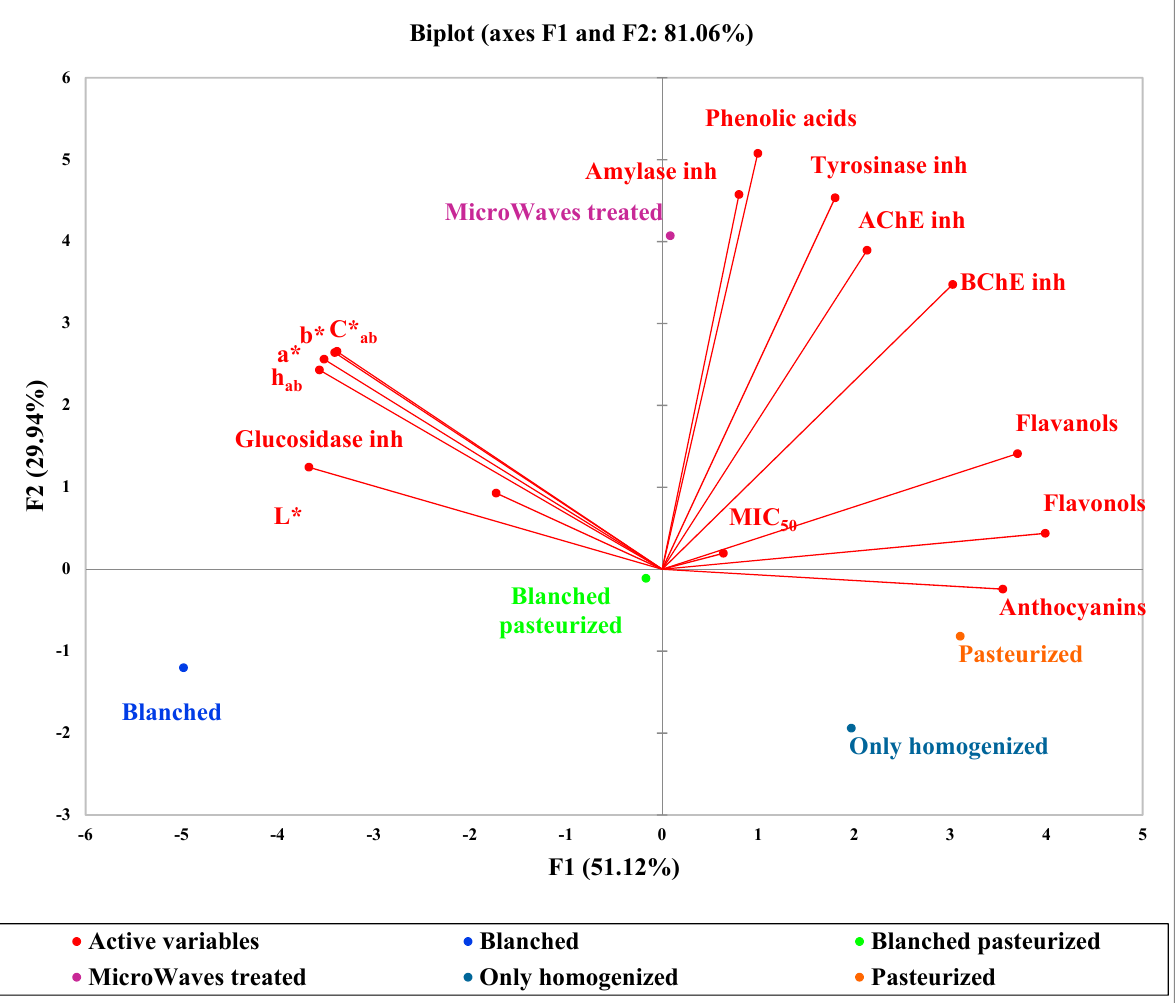
Figure 2. Principal component analysis (PCA) plots of the fresh analyzed Clery samples evaluated as series.